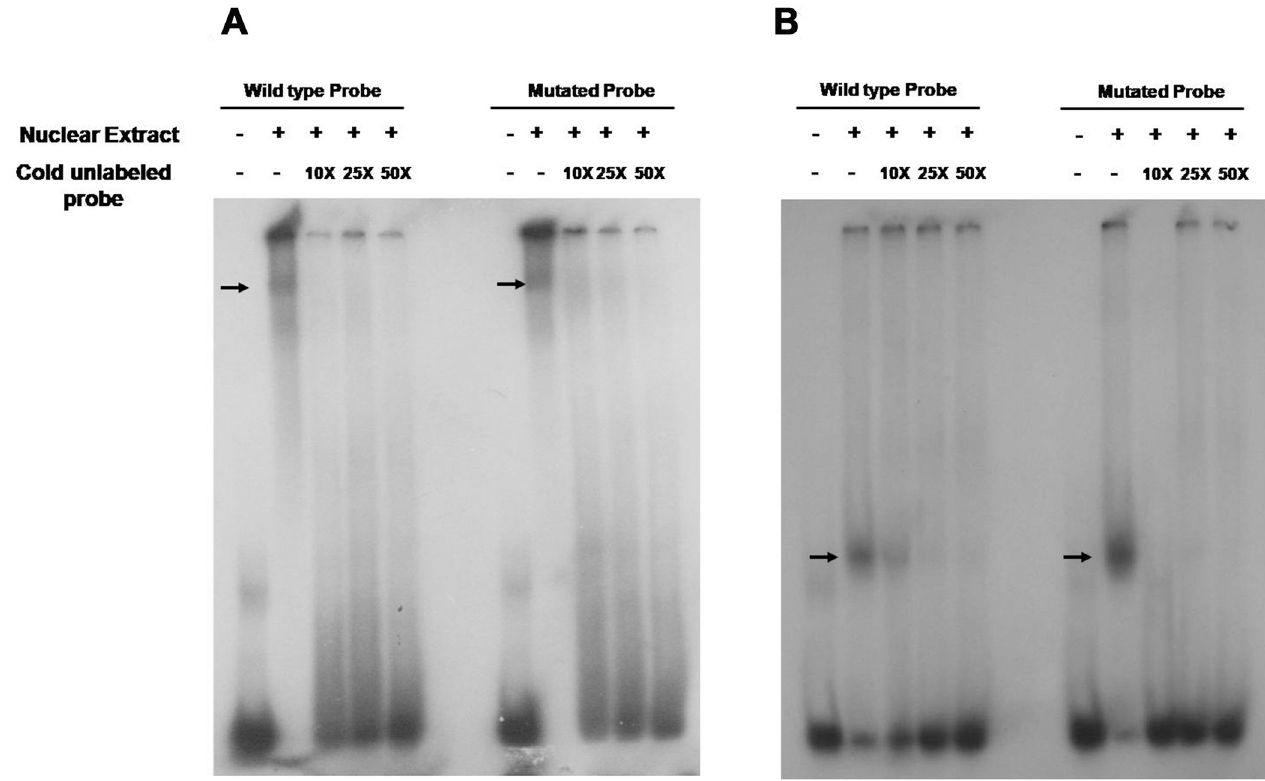
Fig 5. Electrophoretic mobility shift assay was performed on nuclear proteins extracted from human SH-SY5Y cells for RELN variants. (A) rs3914132 and (B) rs74503667 in intron 2 of RELN gene with either wild or mutant probes with (0X, 10X, 25X 50X) and without competitors. DNA-protein complex migration pattern was detected in both wild type and mutated probes for both the variations. The arrow indicates the DNA-protein binding at the sites of these variations.